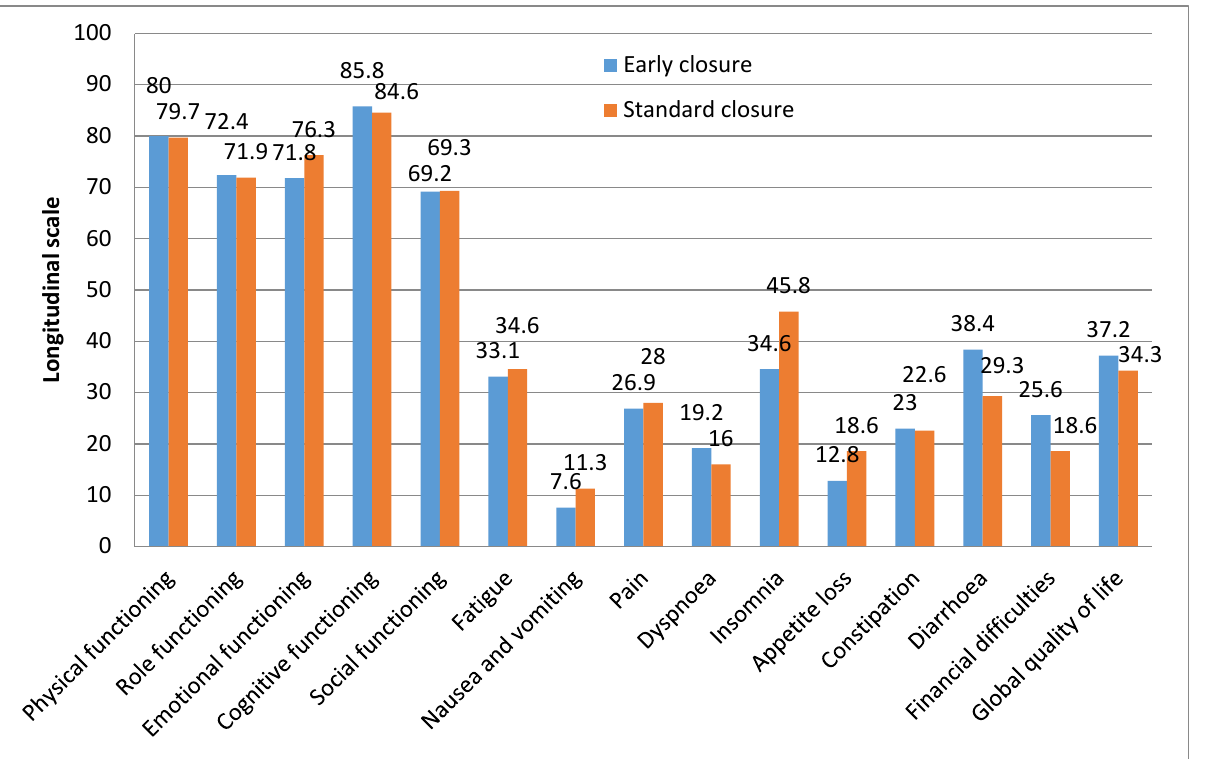
Table 2. Low anterior resection syndrome (LARS) score for patients undergoing early (EC) or standard ileostomy closure (SC).